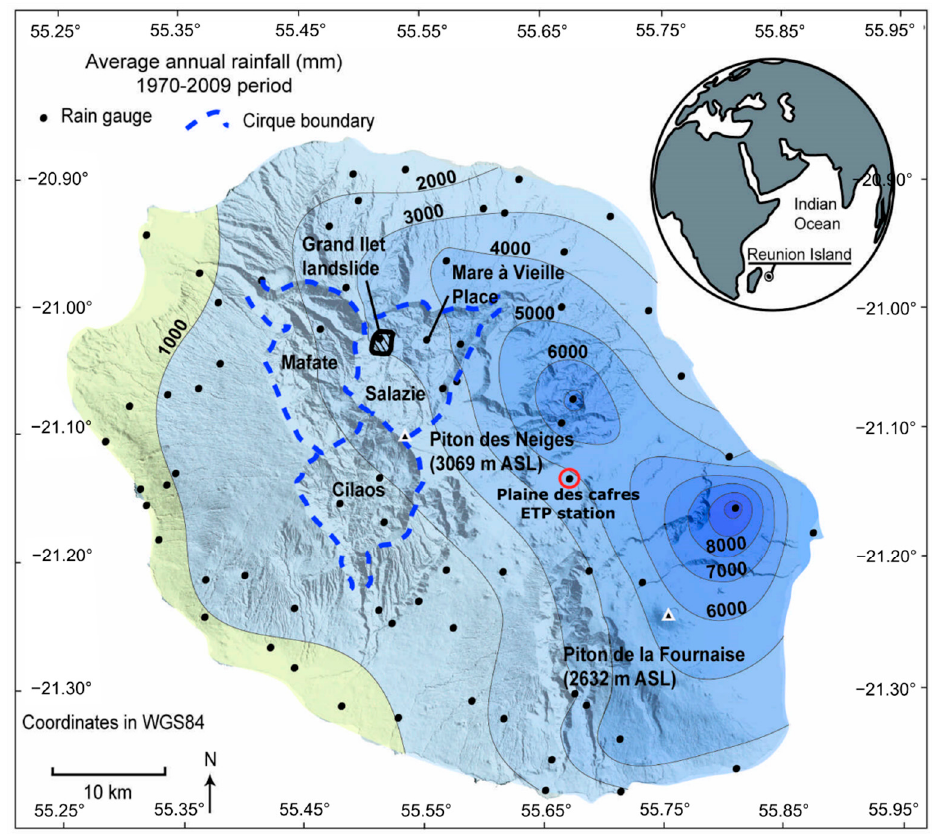
Figure 2. Morphology and rainfall [54] of Reunion Island and location of the Grand Ilet study area in the Salazie